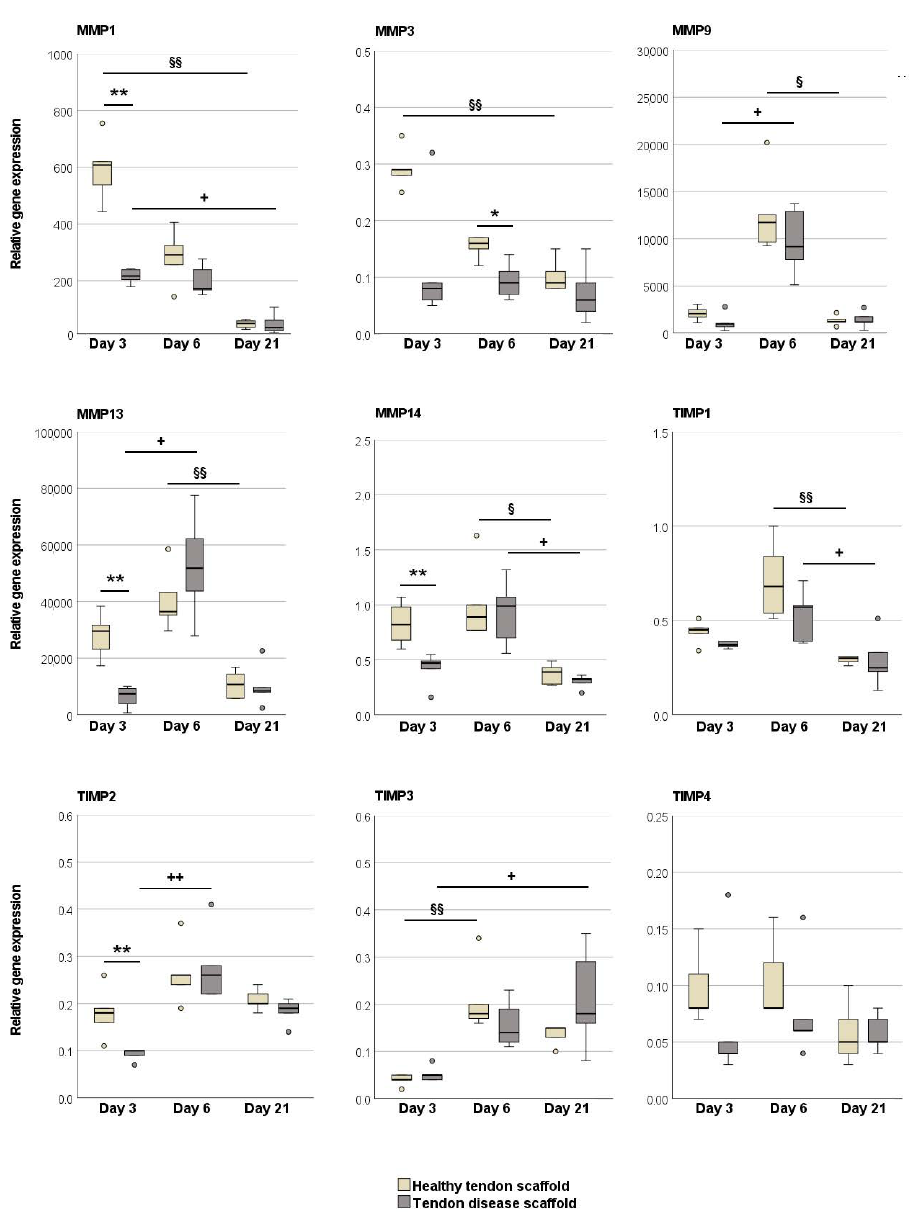
Figure 6. Relative gene expression of matrix metalloproteinases (MMPs) and tissue inhibitors of metalloproteinases (TIMPs) in MSCs seeded on healthy and diseased tendon scaffolds. Asterisks indicate significant differences between groups with p < 0.05 (*) or p < 0.01 (**). Significant differences over time are indicated by paragraph symbols for healthy tendon scaffold cultures and by plus symbols for diseased tendon scaffold cultures (§ or + for p < 0.05; §§ or ++ for p < 0.01). Data were obtained using scaffolds from n = 5 different tendons per